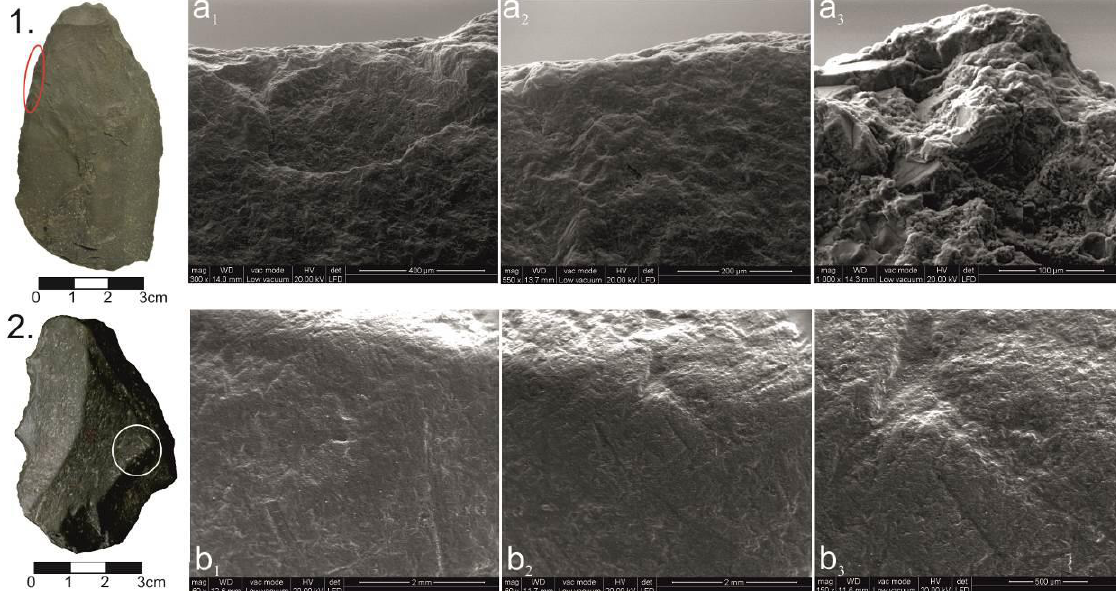
Fig. 12 – Examples of wear and PDSM features on some of the basalt archaeological flakes observed under the SEM (low vacuum mode): top line, artefact I49-unII-32-2010 - left lateral edge (area studied is circled) with evidence of micro-flaking (a ), edge damage with some light rounding (a 1 respectively; Lower line – dorsal surfaces of archaeological basalt flakes (area studied is circled) with generalised heavy rounding, abrasion and randomly distributed striations (b